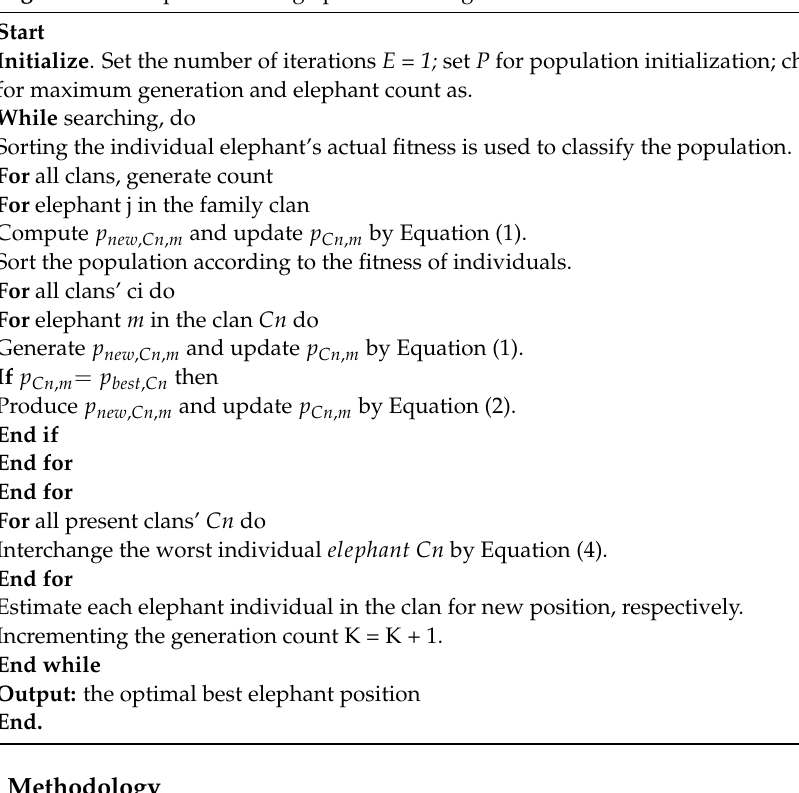
Algorithm 1: Elephant herding optimization